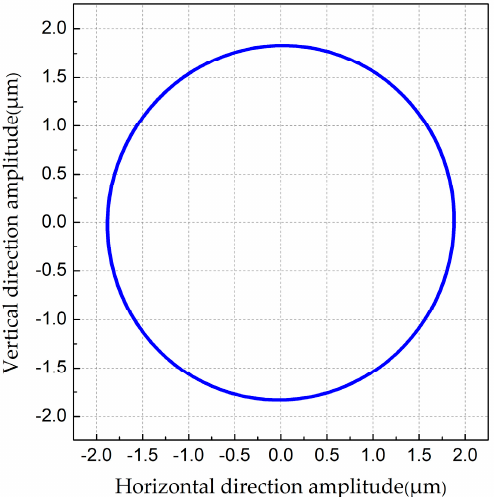
Figure 4. The movement trajectory of driving foot in one period.